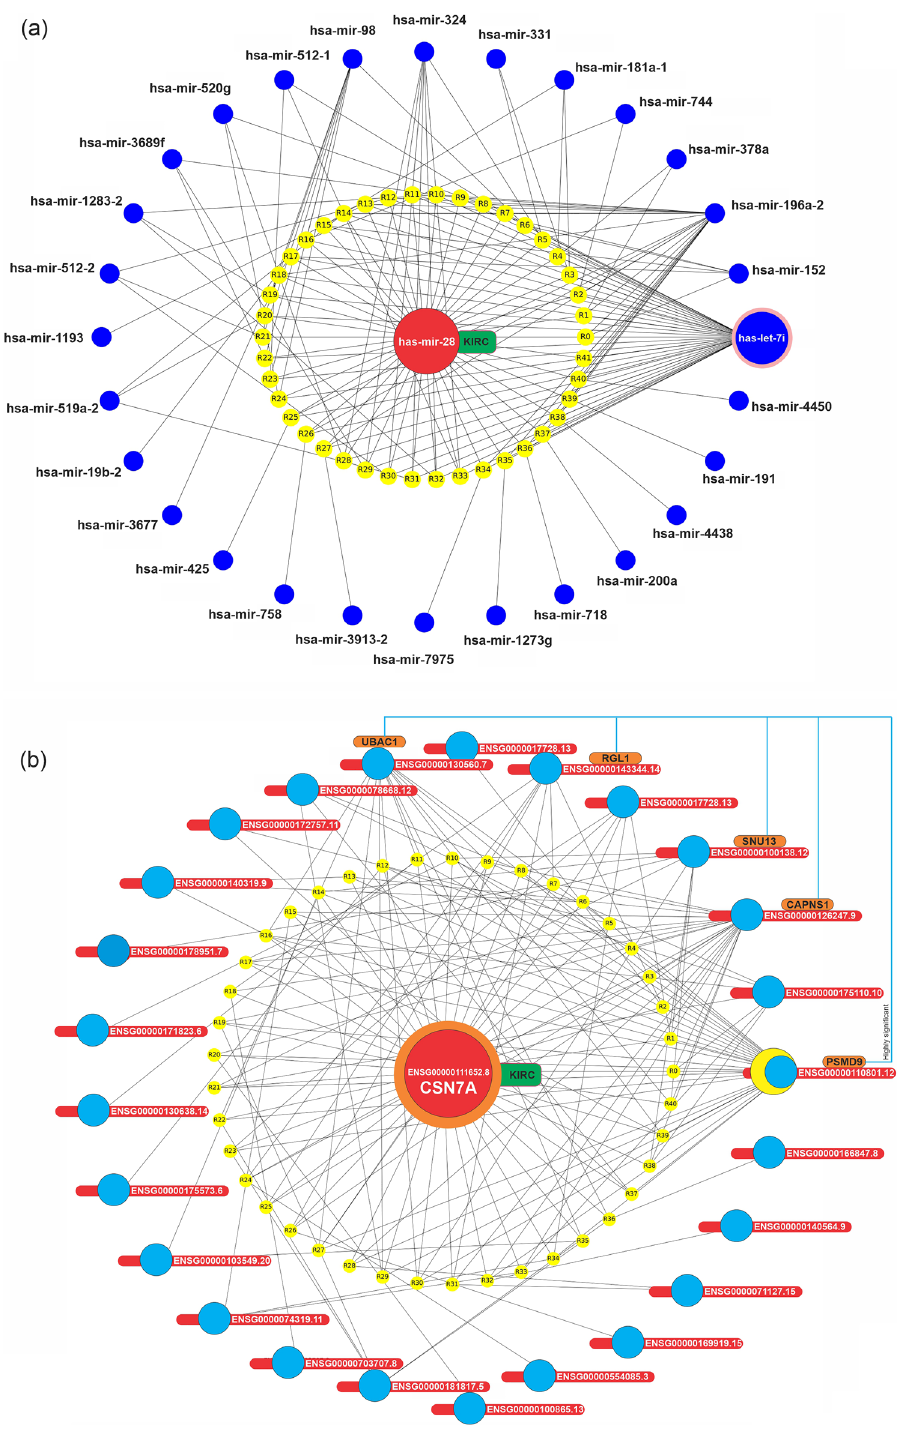
Figure 7. The relationship and specification of the miRNAs and mRNAs are based on the KIRC association rules. Graph network of ( a ) has-miR-28 (with support > 1.66) related association rules, in which the identified miRNA, its rules, and miRNAs were presented, in orange, yellow, and blue colors, respectively. ( b ) Graph network of ENSG00000111652.8 related association rules (with support > 0.3 and lift > 1.4), in which ENSG00000111652.8, rules, mRNAs were presented, in red, yellow, and blue colors,